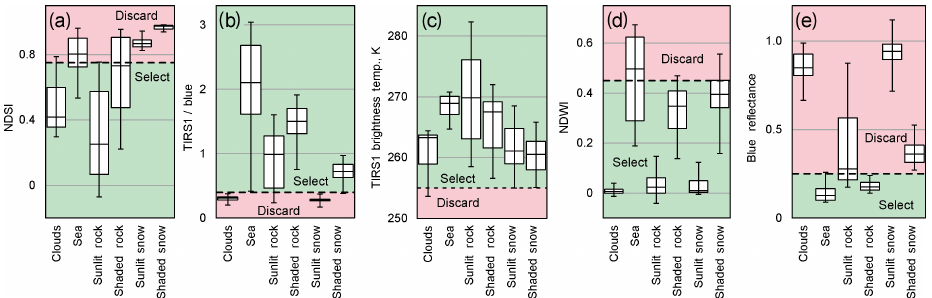
Figure 6. Box plots of extracted pixel values from three Landsat 8 tiles illustrating the different spectral properties of clouds (number of extracted pixels, n = 871), sea ( n = 3277), sunlit rock ( n = 1158), shaded rock ( n = 1224), sunlit snow ( n = 1293) and shaded snow ( n = 918). TIRS1 brightness temperature, blue reflectance and the TIRS1/blue values are converted from the scaled values of the TOA- corrected and brightness-temperature-converted Landsat 8 products (Sect. 2.2). Boxes indicate the 2nd and 3rd quartiles and median values. Whiskers indicate the 5th and 95th percentile. Dashed lines indicate the chosen threshold values for the automated rock outcrop extraction and the values to be selected (green) or discarded